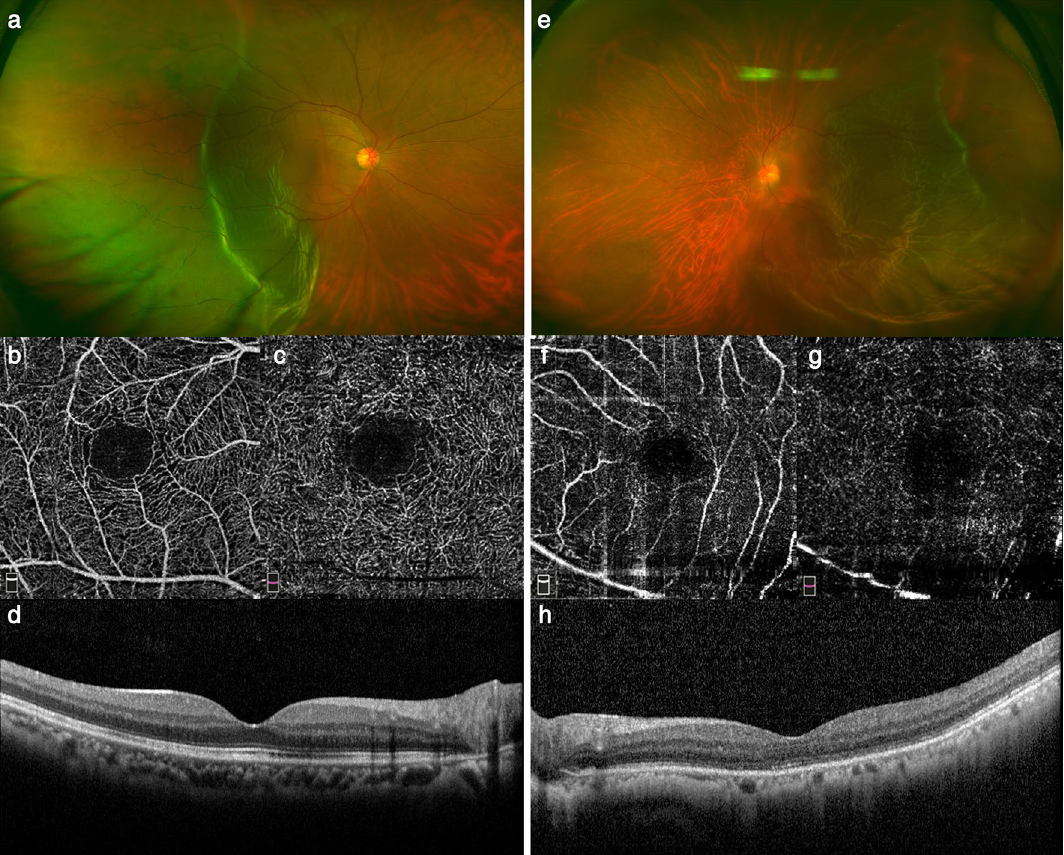
Figure 3. Representative case comparison between early and delayed reattachment after macula-off rhegmatogenous retinal detachment. Left column images ( a – d ) show images of retinal detachment with early reattachment (47 years old, initial vision of 20/1000, 2 days of detachment). Right column images ( e – h ) show images of retinal detachment with delayed reattachment (68 years old, initial vision of 20/630, 21 days of detachment). Both eyes underwent pars planar vitrectomy endolaser photocoagulation and perfluoropropane gas endotamponade. A wide color fundus photo ( a and e ) shows preoperative macular off rhegmatogenous retinal detachment. Postoperative optical coherence tomography angiography ( b , c and f , g ) images indicate better vascular density and a smaller foveal avascular zone area in early reattachment than in delayed reattachment. Early reattachment was associated with a good macular ellipsoid zone and a good final vision (20/25), while delayed reattachment was associated with a disrupted macular ellipsoid zone and a suboptimal final vision (20/100) ( d and h ).